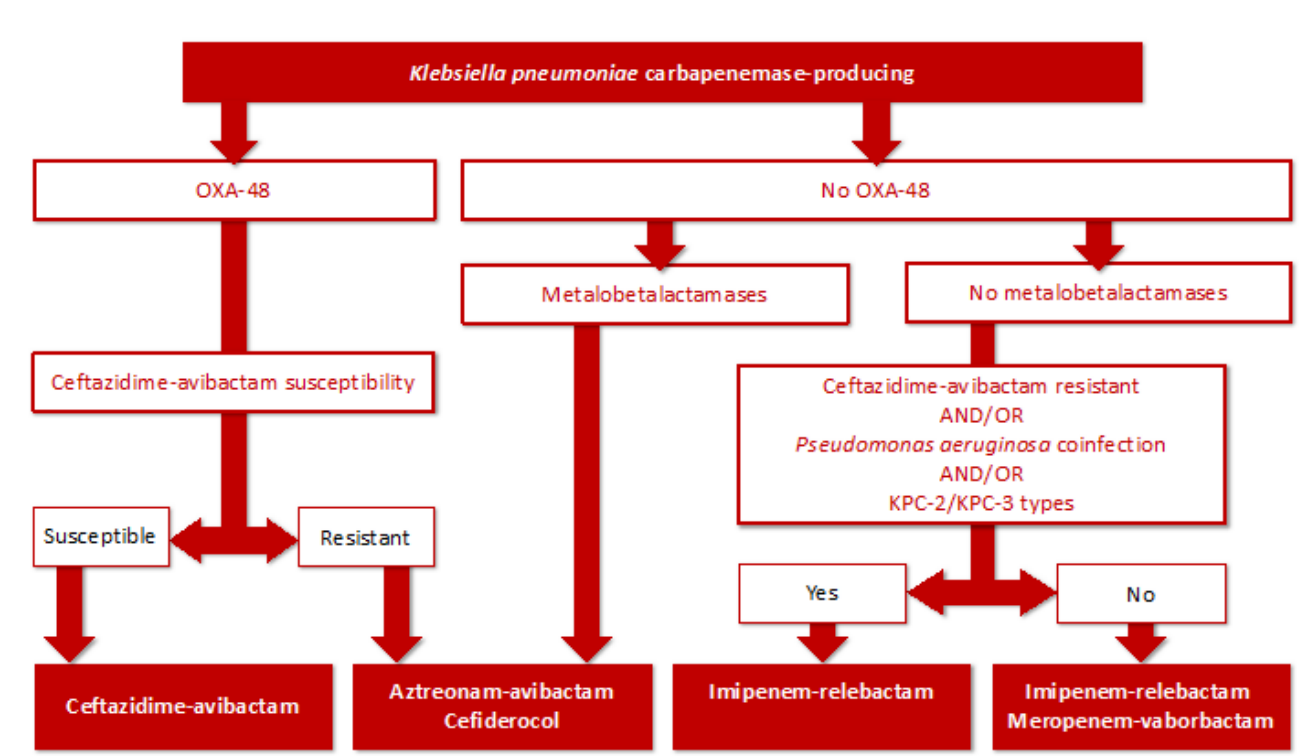
Figure 3. KPUCI * algorithm decision to use the new drugs reported against carbapenemase-pro- Figure 3. KPUCI algorithm decision to use the new drugs reported against carbapenemase-producing ducing K. pneumoniae . * KPUCI: Klebsiella pneumoniae in ICU group. K. pneumoniae . KPUCI: Klebsiella pneumoniae in ICU